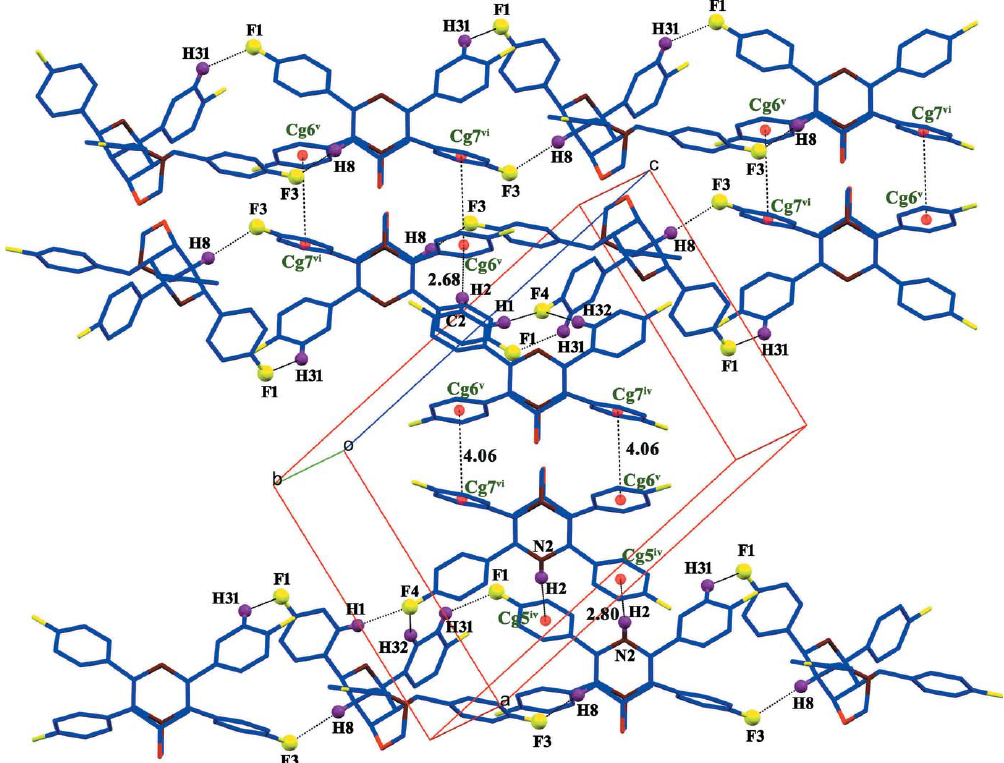
Figure 2 A view of the supramolecular architecture of the title compound. Some of the atoms have been omitted for clarity.